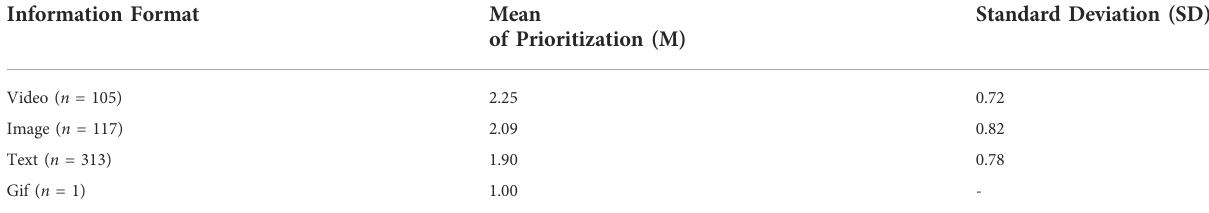
TABLE 2 Information format and